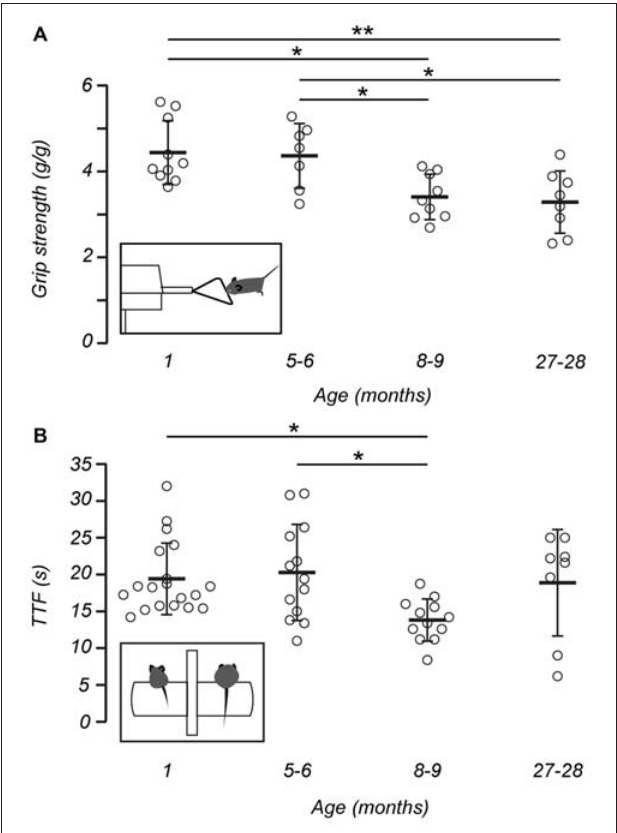
FIGURE 2 | Gross motor performance and grip strength declines with age. (A) The grip strength of mice, normalized for weight, declined with age. Post hoc analysis showed 1 ( n = 10) and 5–6-month-old mice ( n = 7) were stronger than 8–9-month-old mice ( n = 9) and 27–28-month-old mice ( n = 8). Inset shows a representation of a mouse undergoing the grip strength test. (B) Measurements of time to fall (TTF) decline with increasing age. Post hoc analysis showed differences in TTF between 1 ( n = 19) and 8–9-month-old mice ( n = 12), and 5–6 ( n = 13) and 8–9-month-old mice. No difference was observed between 27–28-month-old mice ( n = 8) and other age groups. Inset shows a schematic of a 1-month-old mouse (left) and 8–9 –month-old mouse (right) on the rotarod apparatus in preparation for the rotarod test. Open circles represent the mean recorded for individual mice, horizontal bars indicate the mean for each age group, error bars = SD , ∗ p < 0.05, ∗∗ p <